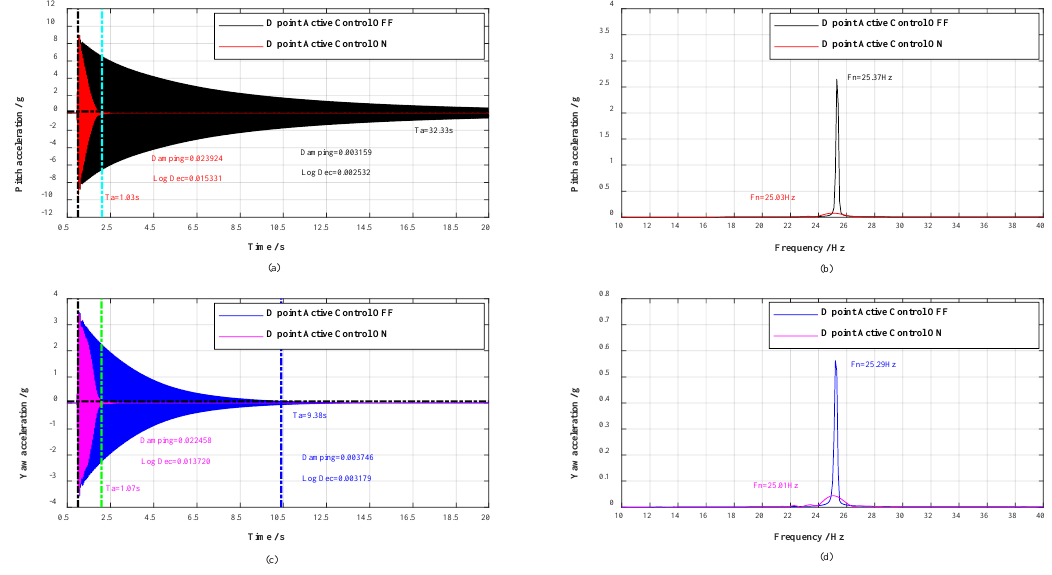
Figure 9. Response spectral analysis. Control effect during impulse tests in any plane (D point).